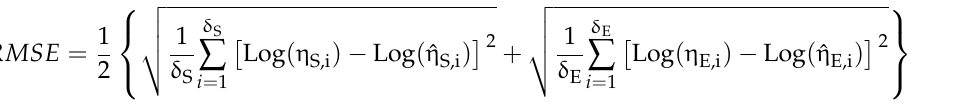
Table 2. Generalized Newtonian model parameters for T = 180 °C, ψ = 8.